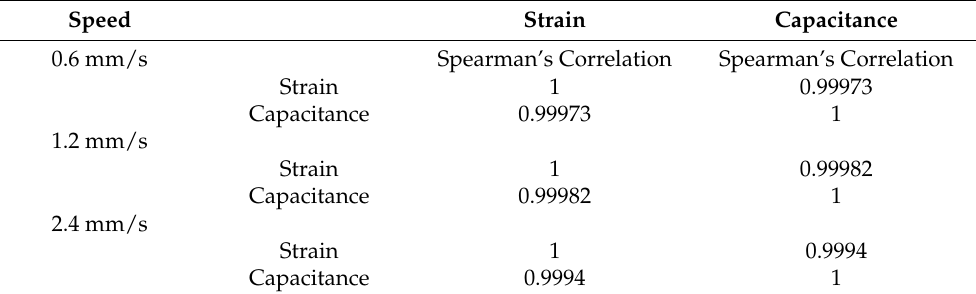
Table 3. Spearman’s Rank Correlation Coefficients for the Quasi-Static Strain and Capacitance at Each Speed.